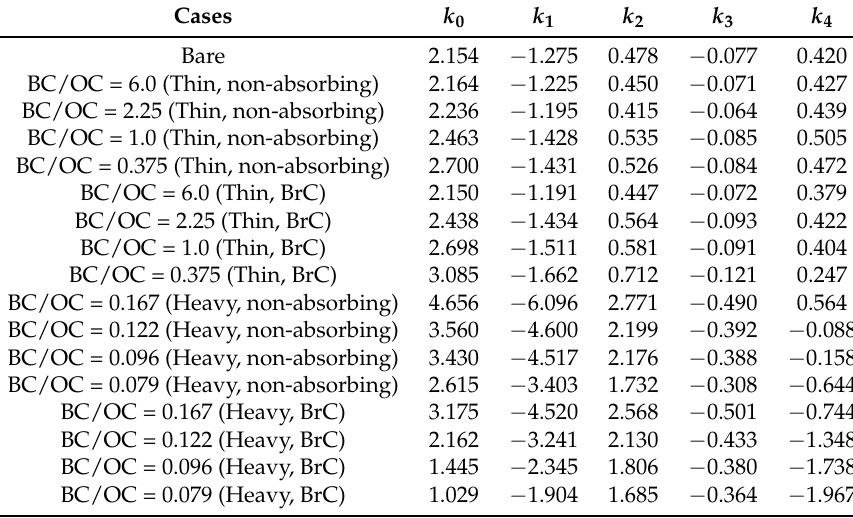
Table A2. Fitting parameters of BC aerosols for EAE (350–700